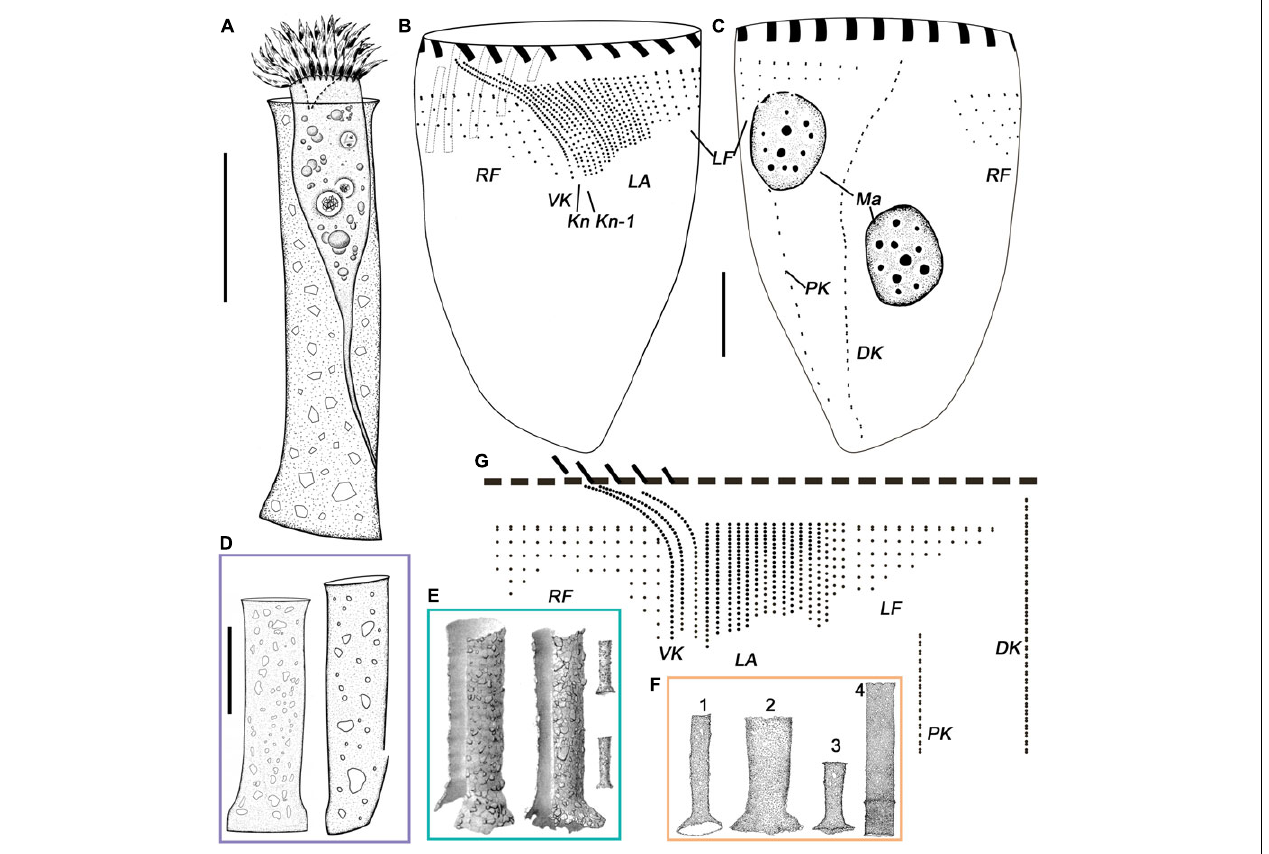
FIGURE 1 | Leprotintinnus nordqvisti from life (A,D–F) and after protargol staining (B,C,G) . (A) A typical individual. (B,C) The ciliary pattern of ventral and dorsal sides of the same specimen. (D) Different shapes of loricae with agglomerated mineral particles. (E) Lateral view of loricae from Brandt (1906). (F) L. nordqvisti from Roxas (1941) (except for 4, original named L. tubulosus ). (G) Kinetal map of a morphostatic specimen. DK, dorsal kinety; K n , the last kinety of the lateral ciliary field; K n - 1 , the penultimate kinety of the lateral ciliary field; LA, lateral ciliary field; LF, left ciliary field; Ma, macronuclear nodules; RF, right ciliary field; VK, ventral kinety. Scale bars: 20 µ